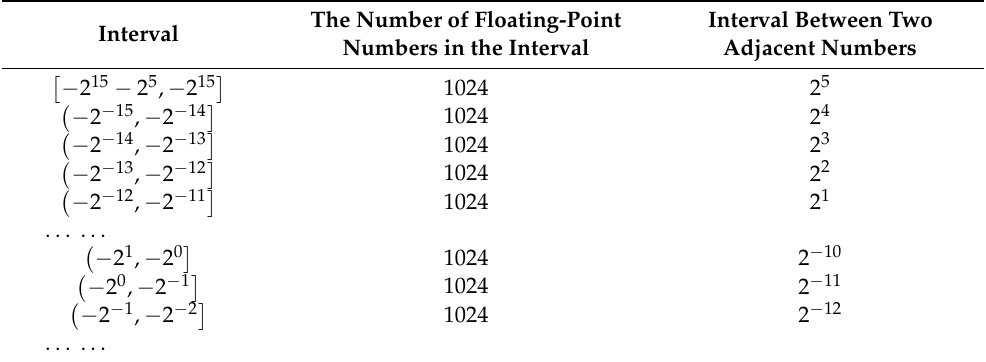
Interval Between